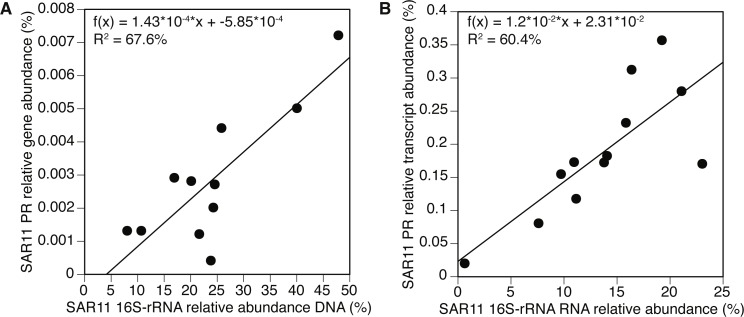
Positive correlation between 16S-rRNA and proteorhodopsin (PR) within the SAR11 clade.(A) Relative gene abundance and (B) relative transcript abundance. Sample collected at POLA in April 2013 was considered an outlier and therefore removed from the statistical analysis in (A).